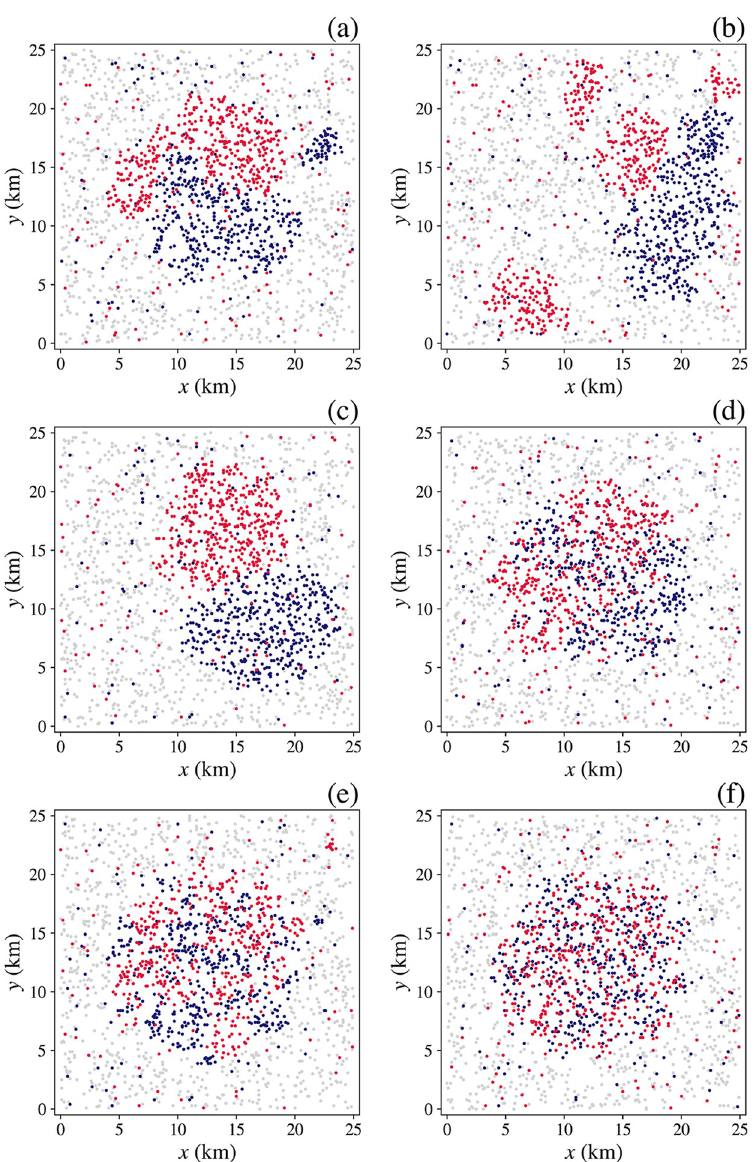
Fig 12. Segregation after 25 years of equal numbers of households with q 1 = 1 (red) and q 1 = -1 (blue). Dwellings have general utility U 0 distributed as previously centered at (12.5, 12.5). Characteristic type q 1 and neighborhood size h are set to the following combinations: ( a ) h = 1 km, q 1 = ± 1, ( b ) h = 1 km, q 1 = ± 2, ( c ) h = 2 km, q 1 = ± 1, ( d ) h = 1 km, q 1 = ± 0.5, ( e ) h = 0.5 km, q 1 = ± 1, ( f ) h = 1 km, q 1 = ±